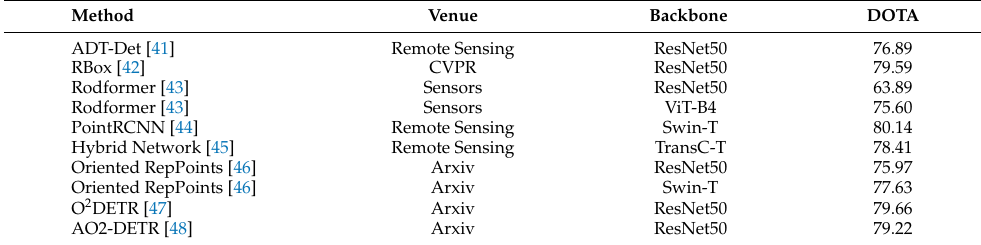
Table 2. Comparison in terms of detection accuracy (mAP) of different detectors utilizing a hybrid CNN-transformer design, transformers pre-trained backbone or a DETR-based transformer architec- ture on DOTA benchmark. The results are presented on the orientated bounding-boxes task of the DOTA